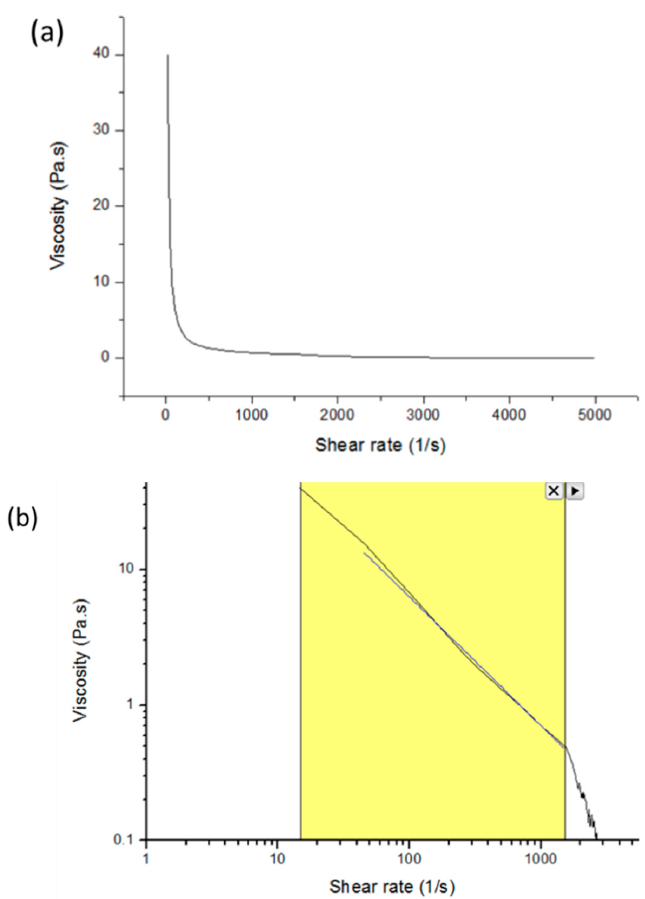
Figure 1. ( a ) Viscosity vs. shear rate cure and ( b ) viscosity and shear rate in linear region for curve fitting ( yellow region ) in log - log scale .